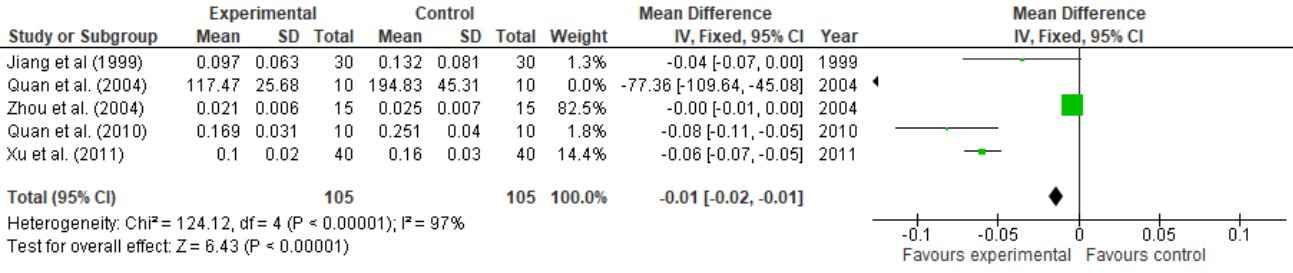
Figure 12. Lactulose/mannitol ratio: fixed-effects meta-analysis and forest plot from studies providing supplementation of glutamine.